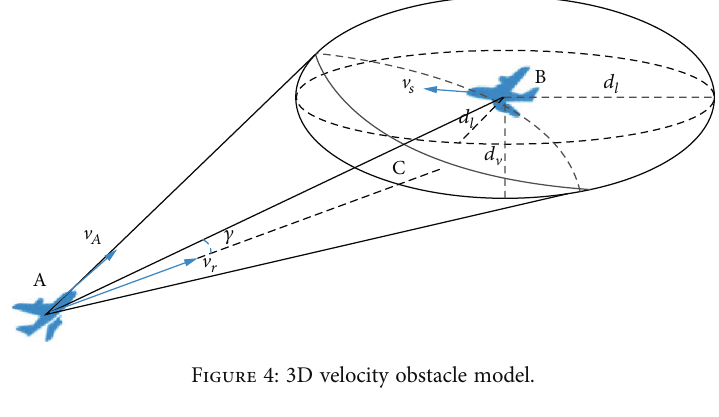
Figure 4: 3D velocity obstacle model.